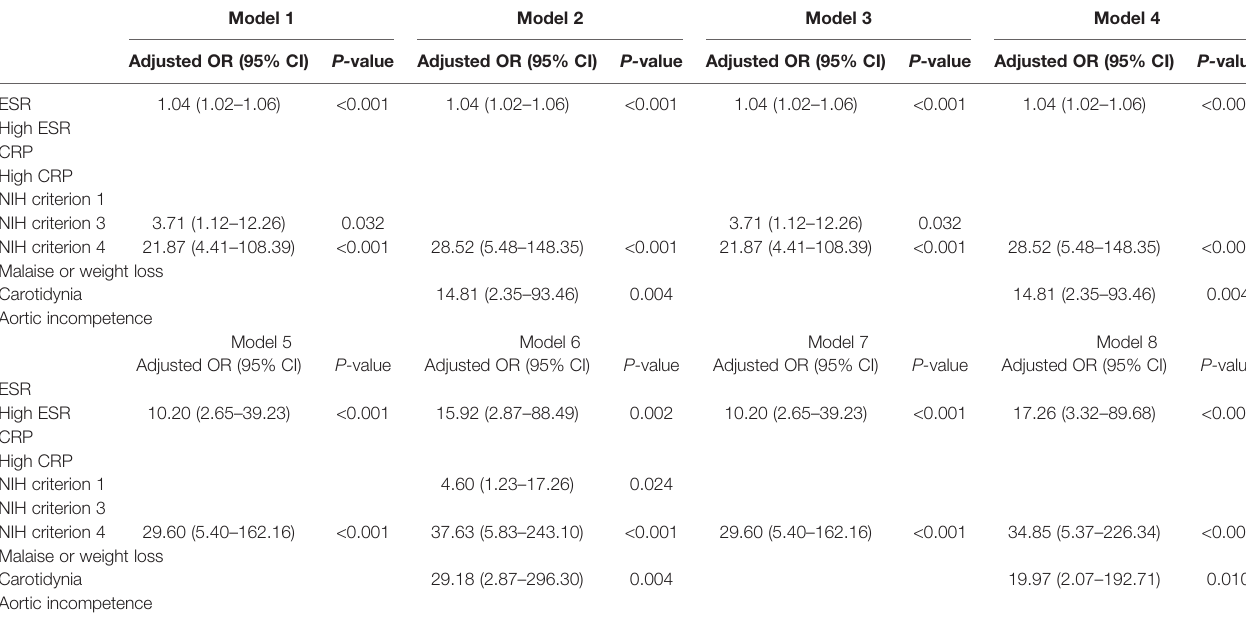
TABLE 3 | Multivariable models using stepwise regression.